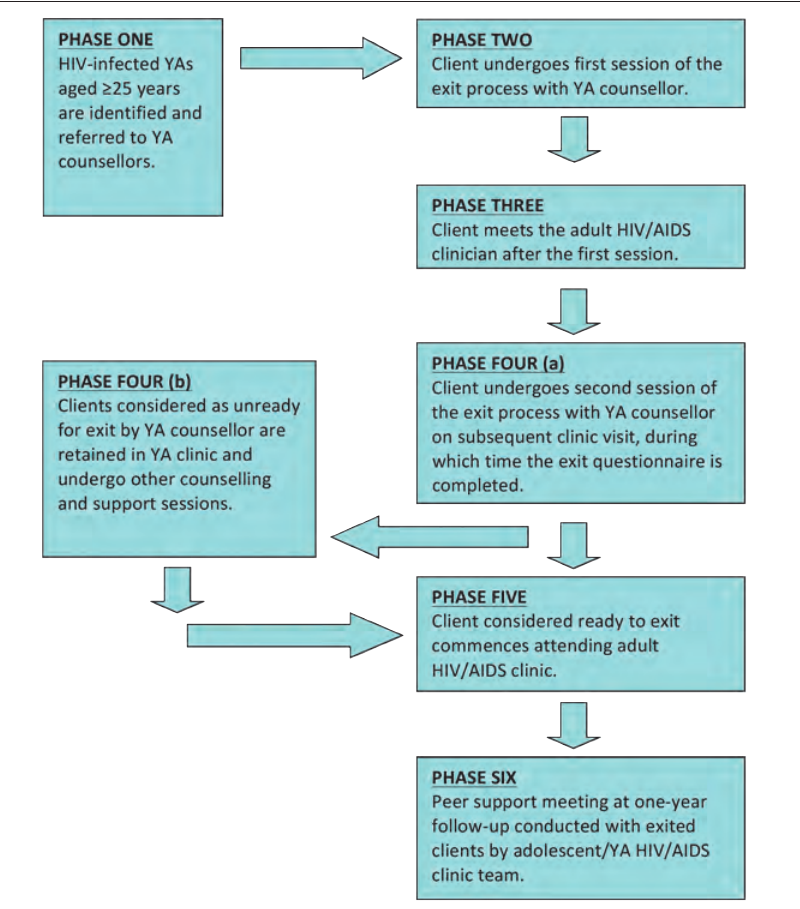
Fig. 1. The Infectious Diseases Institute (IDI) young adult HIV transition model. YA = young